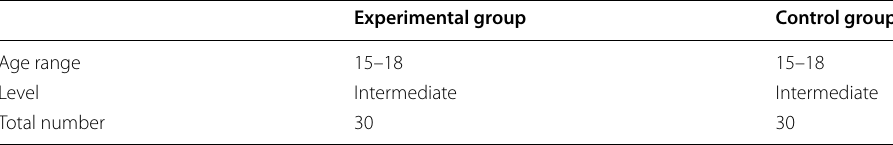
Table 1 Distribution of